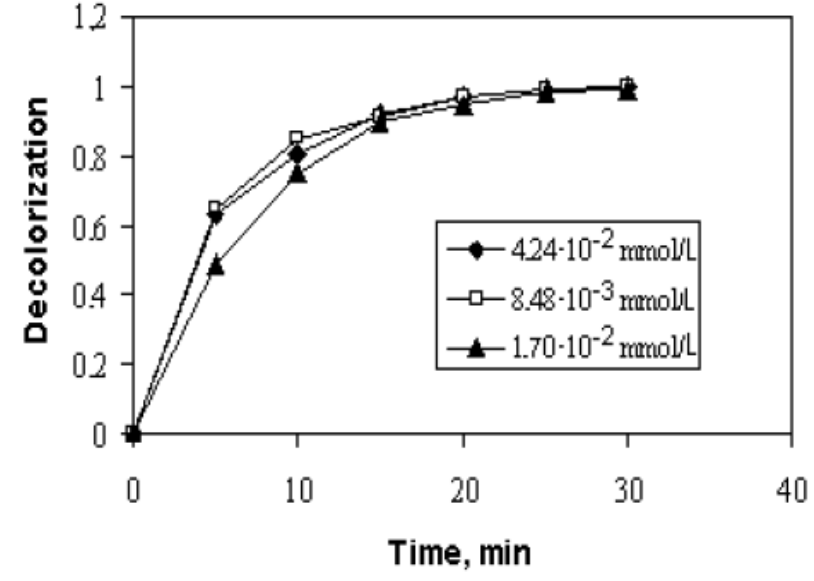
Fig. 8 Effect of Co 2+ ions on AOP in neutral medium. Initial conditions: C dye =50 mg/L, [H 2 O 2 ]= 17.318